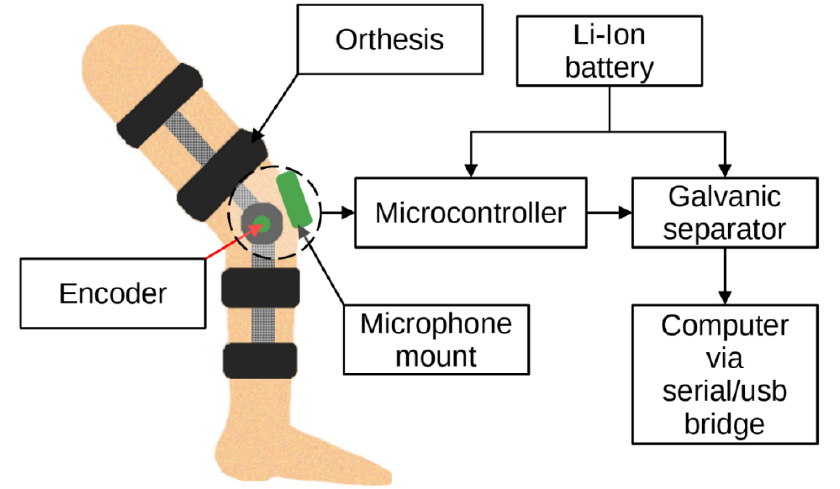
Figure 4. Main modules of the measurement system.